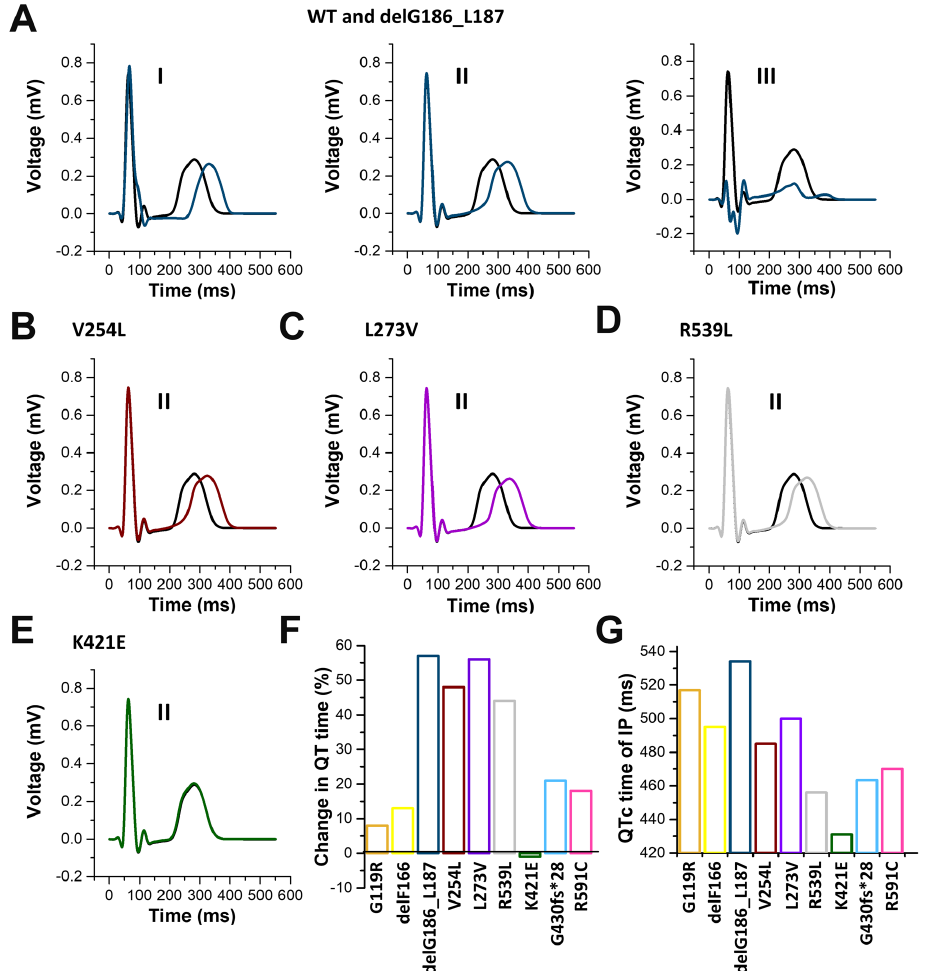
Figure 9. Simulated surface electrocardiograms (ECGs) based on the variant-specific changes to the action potentials predicted by the ten Tusscher model of human ventricular myocytes (Figure 8). ( A ) ECG of leads I, II, and III of wild-type KCNQ1 (black) and the variant delG186_L187 (blue). Examples of lead II of the calculated surface ECG for wild-type (black) and the variants ( B ) V254L (brown), ( C ) L273V (purple), ( D ) R539L (gray), and ( E ) K421E (green). ( F ) Quantification of the percentage of change in the QT time for the different variants. ( G ) QTc times of the index patients with the different KCNQ1 variants. Note, that for the G430fs*28 variant, the mean QTc time of the index patient and the heterozygous mother was illustrated, since the QTc prolongation of the index patient occurred only once and